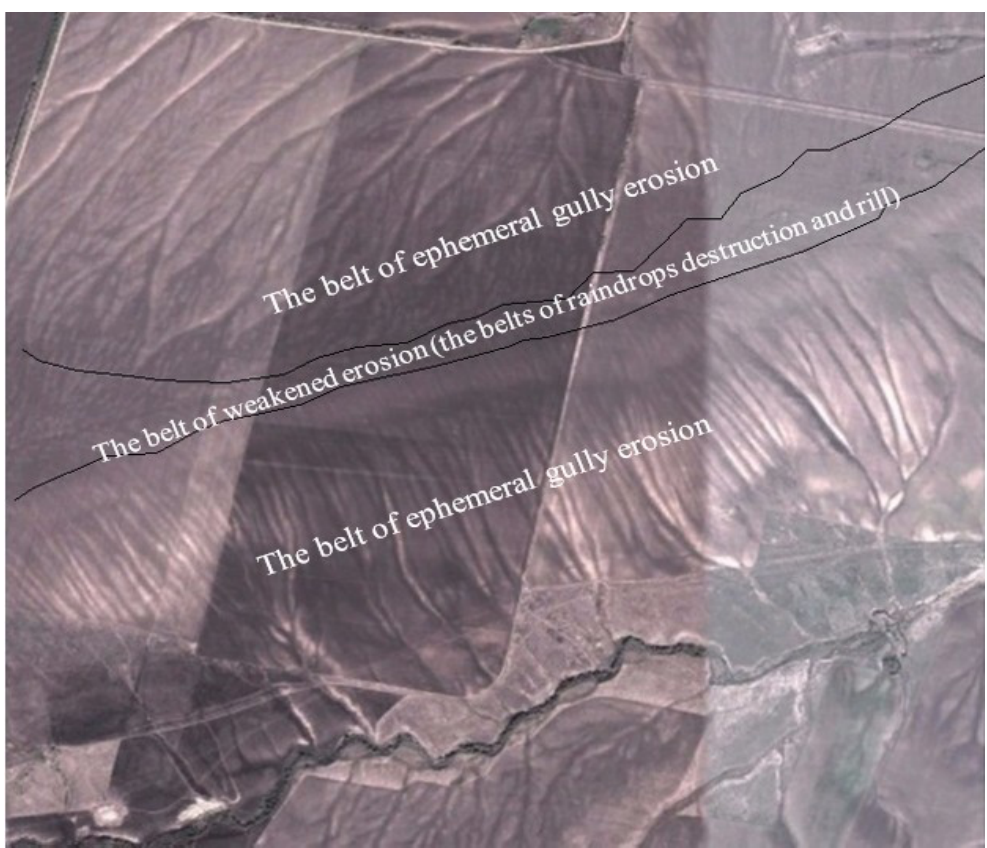
Figure 3. Satellite image interpretation (scale 1:40,000) of the ephemeral gully erosion belt at the interfluve (1 km southwest of the village of Pogromnoye, Orenburg Region). The black line shows the location of the upper boundary of the ephemeral gully erosion belt.